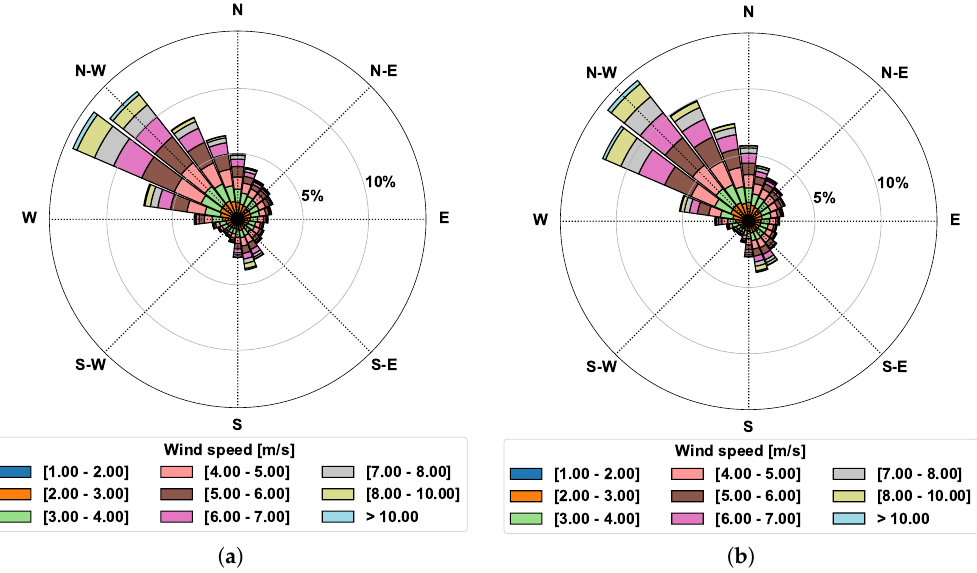
Figure 4. NOAA wind rose at the north node ( a ), and at the south node ( b ), in proximity of the ADM ins , indicating that the atmospheric conditions along this stretch of coast can be considered uniform.